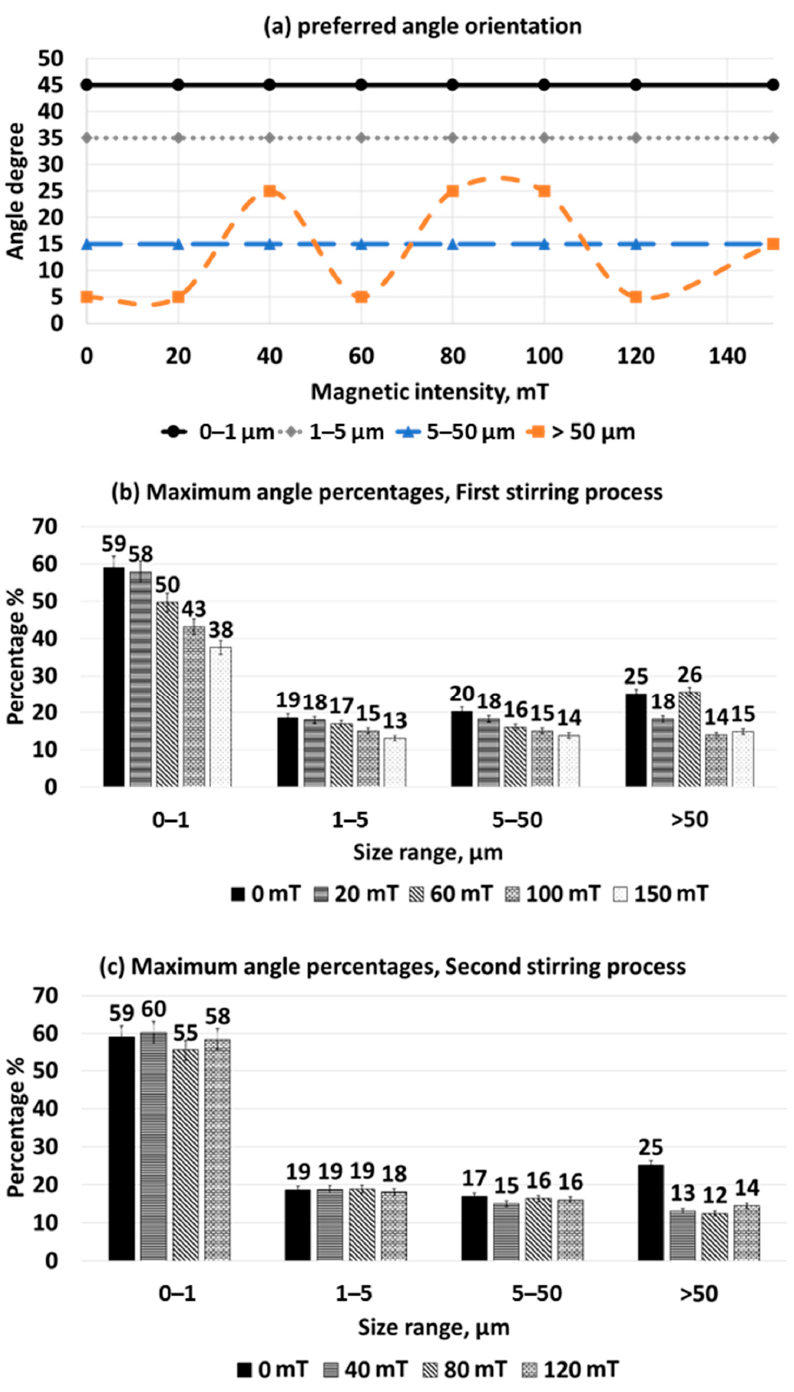
Figure 8. Angle distribution percentages for different size ranges. ( a ) Preferred angle distribution for each size range. ( b ) Maximum percentages of lamellae that orient in the preferred angle for each size range during the first stirring process (Steps 1 and 2). ( c ) Maximum percentages of lamellae that orient in the preferred angle for each size range during the second stirring process (Steps 3 and 4).